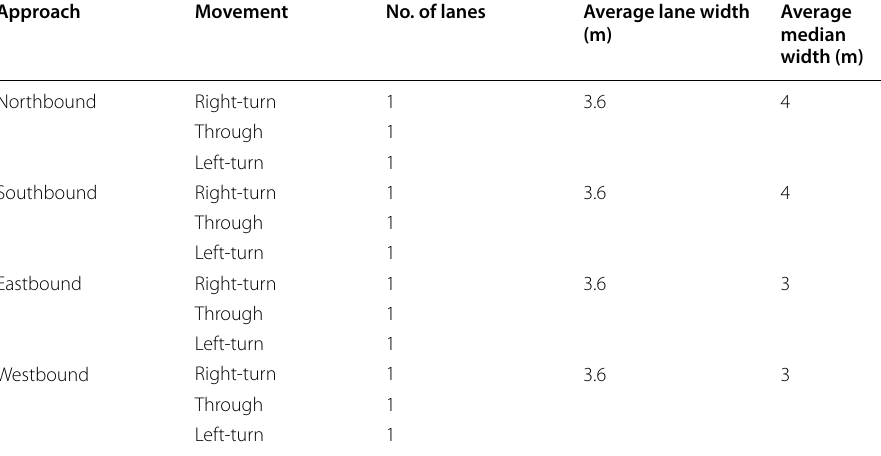
Table 1 Geometric characteristics of Al-Sakhara signalized intersection